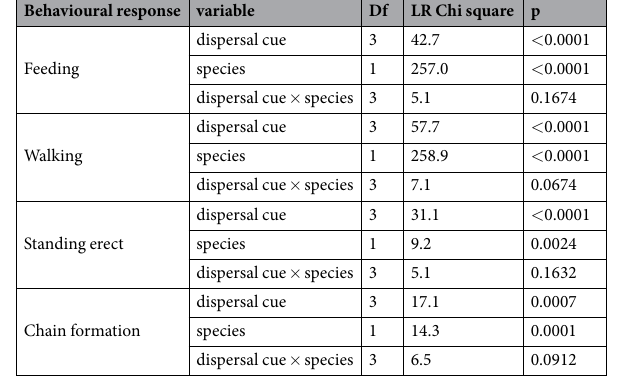
Table 1. Analysis of deviance table testing influence of treatment, species and their interaction (dispersal cue x species) on mite behavioural responses. Model terms, test statistics and associated p -values are